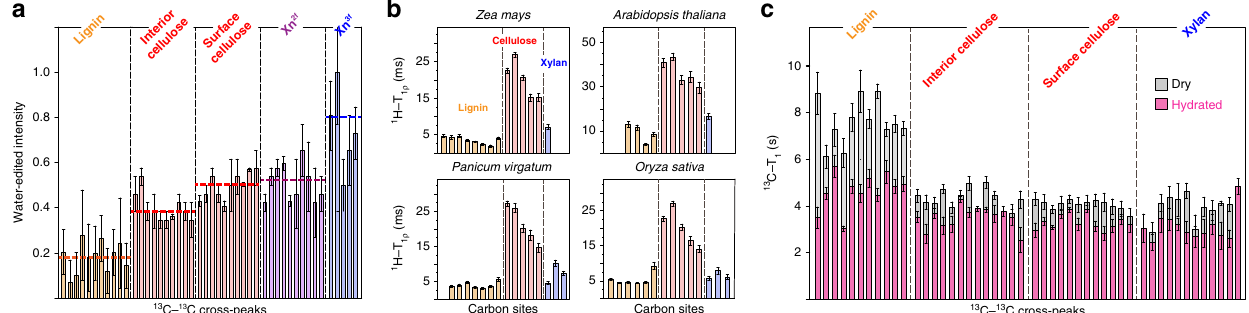
Fig. 5 Lignin is highly hydrophobic and dynamically distinct from polysaccharides. a Water-edited intensities showing the hydration level of molecules in maize. Error bars are standard deviations propagated from NMR sensitivity. The hydration level decreases in the order of three-fold xylan, 2-fold xylan, surface cellulose, interior cellulose and lignin. b 1 H-T 1 ρ relaxation times of four plants detect molecular motions on the microsecond timescale. c 13 C-T 1 relaxation times of hydrated (magenta) and dried (grey) maize re fl ect nanosecond timescale motions. Distinct from the polysaccharide, lignin has long 13 C- T 1 but short 1 H-T 1 ρ relaxation. Error bars are standard deviations of the fi t parameters. The x -axis corresponds to well-resolved cross peaks or carbon sites as tabulated in Supplementary Table 7 – 10. Source Data are provided as a Source Data fi le